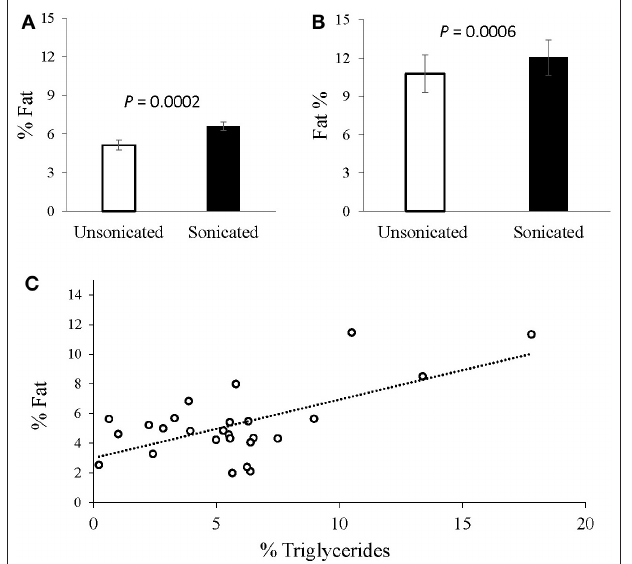
FIGURE 1 | Intrahepatic-fat content analysis with vs. without tissue sonication. (A) Livers extracted from grown male lambs ( n = 30), exhibited greater fat content with sonication applied (6.6 vs. 5.1%; P = 0.0002, SEM = 0.35). (B) Livers extracted from Pregnancy toxemic sheep ( n = 6), similarly showed greater fat content with sonication (12.1 vs. 10.8%; P = 0.0006, SEM = 0.94). (C) Plot of the gravimetrical hepatic-fat contents vs. the triglycerides concentrations determined enzymatically. A moderate overall Pearson correlation was observed ( r = 0.6317; P = 0.005).